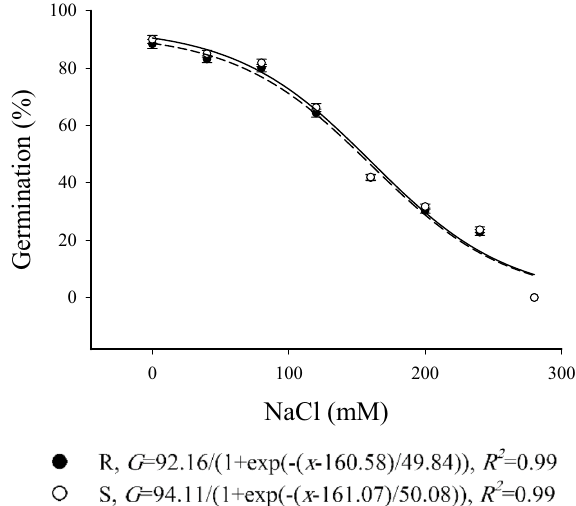
Figure 3. Germination of herbicide-resistant (black circles) and -susceptible (white circles) winter wild oat biotype as affected by different salinities. The data was fit with a three parameter sigmoidal function using